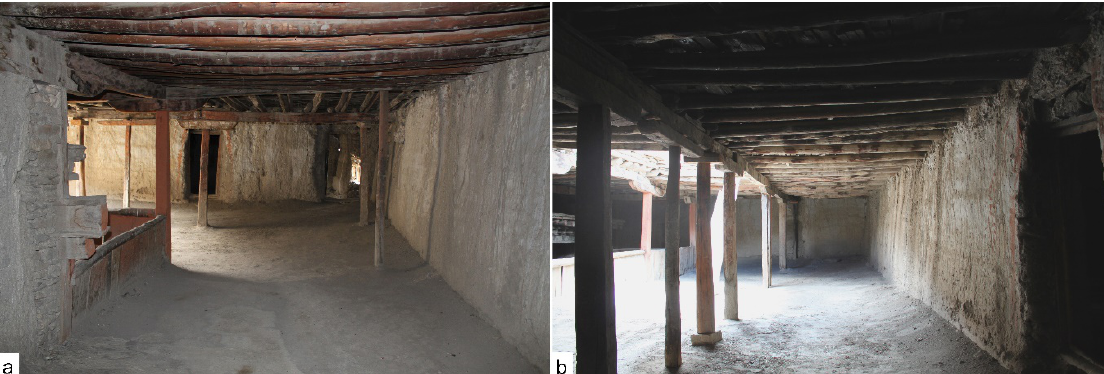
Figure 6. Gönpa Gang first floor: ( a ) southern bay of the gallery above dukhang ; ( b ) eastern bay of the gallery above dukhang.